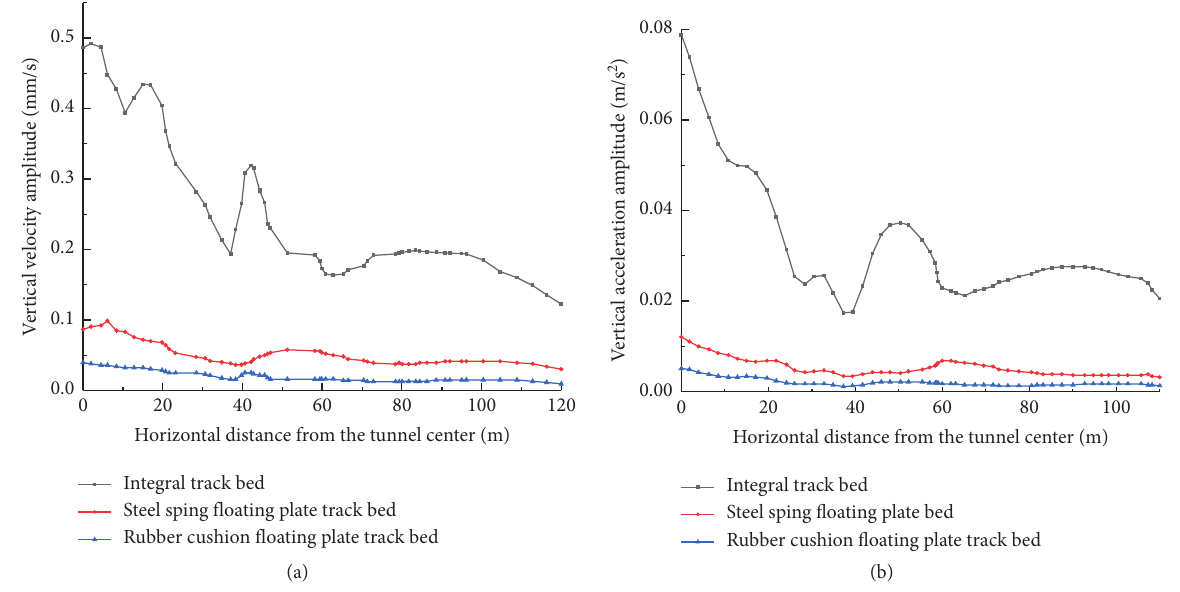
Figure 17: Vertical velocity amplitude (a) and vertical acceleration amplitude (b) varying with horizontal